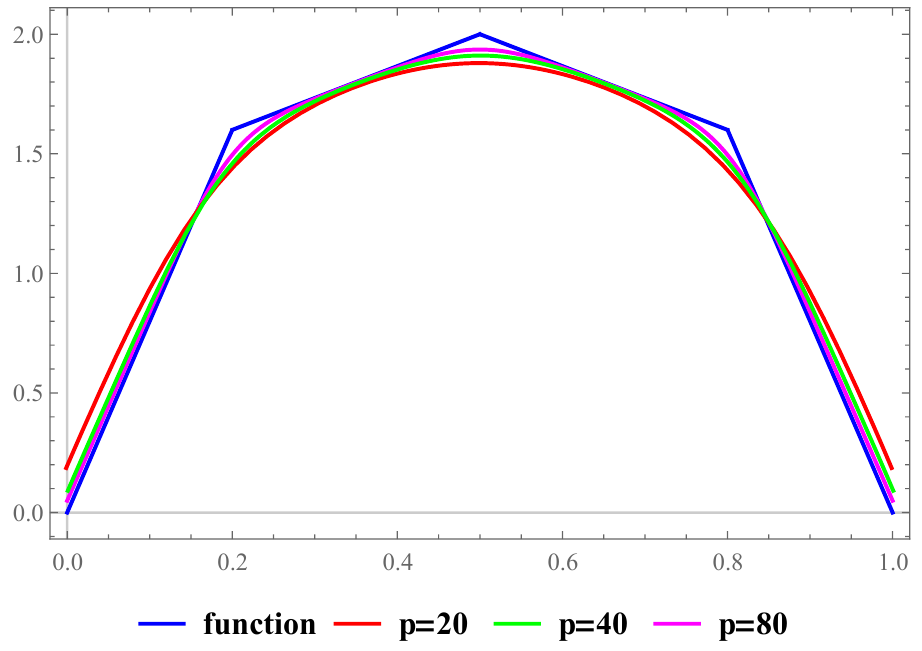
( α , s ) for function r 2 ( u ) p , λ